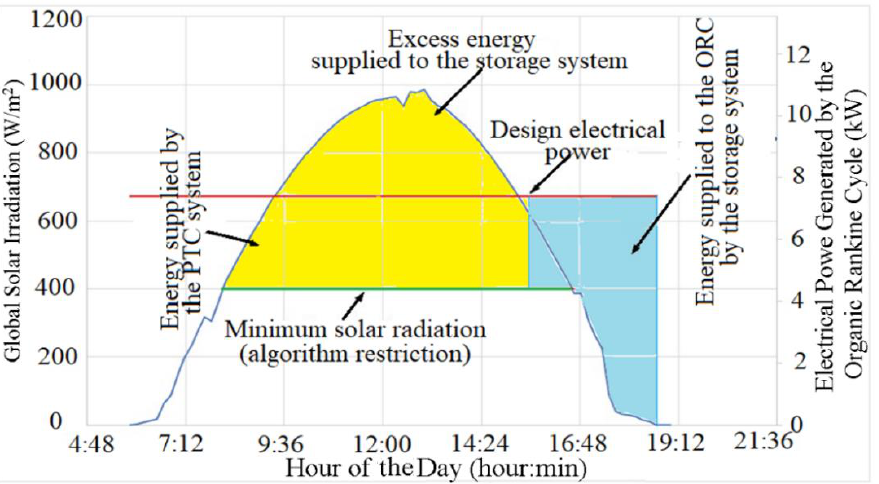
Figure 11. The system’s behavior as a function of solar irradiation in the city of Itajub á , Minas Gerais,